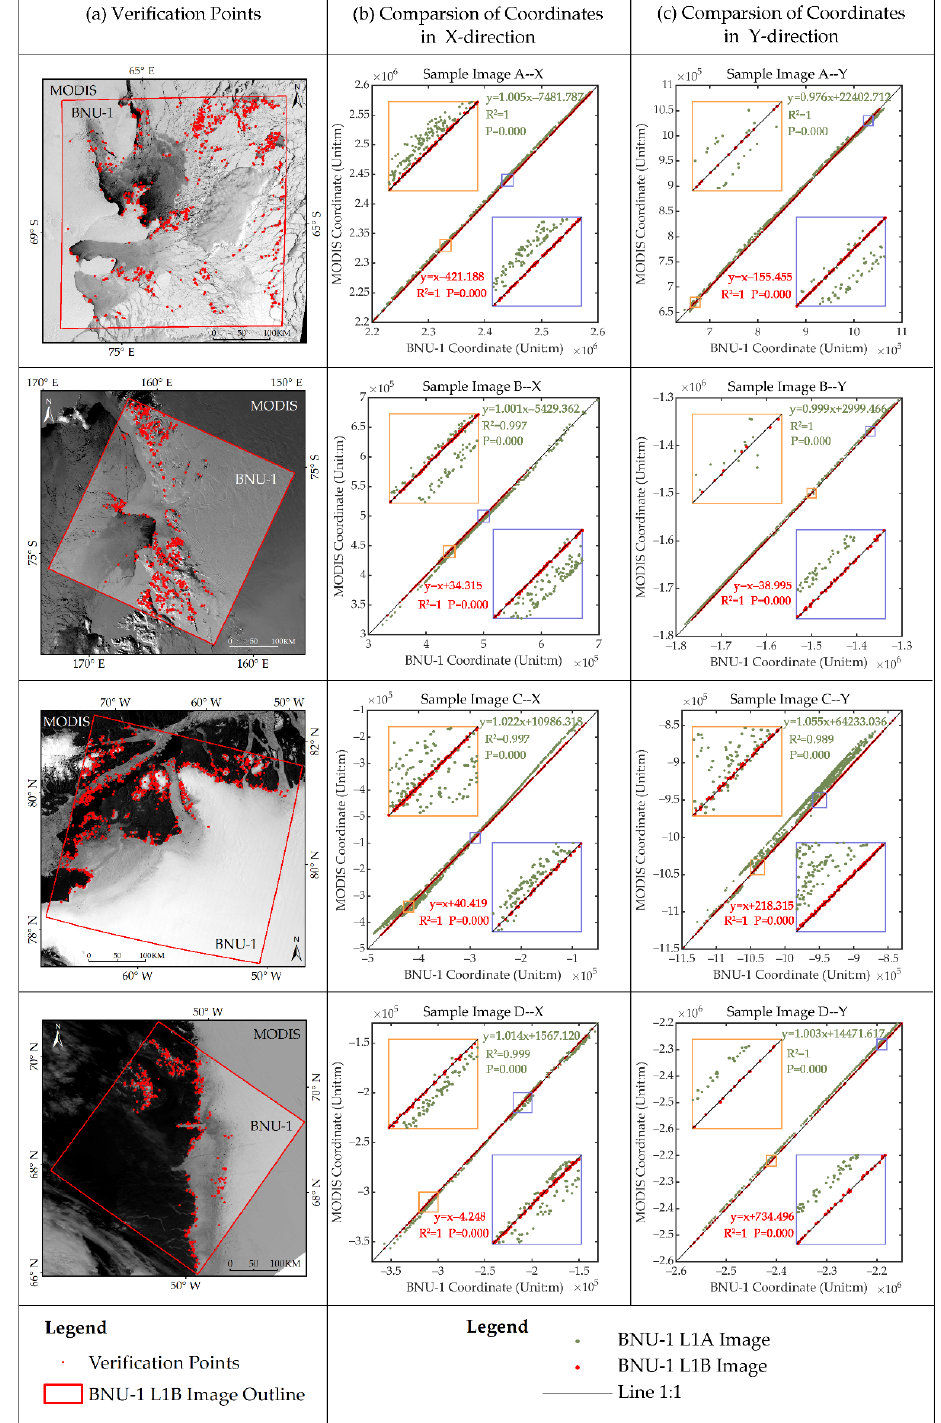
Figure 10. Spatial distribution of the verification points for accuracy evaluation of BNU-1 L1B Sample Images A, B, C, and D ( a ); and the coordinates comparison of the verification points of BNU-1 L1A/L1B Sample Image A, B, D, and E and their corresponding MODIS images, in X-direction ( b ) and Y-direction ( c ), respectively. Green and red dots represent the verification points on the BNU-1 L1A image and the BNU-1 L1B image, respectively. The black diagonal line in the sub-figures represents that the coordinates of points in the BNU-1 image are almost equal to those in the corresponding MODIS image. The two small graphs in each sub-graph are the enlarged version of the orange and blue rectangular areas on the black diagonal